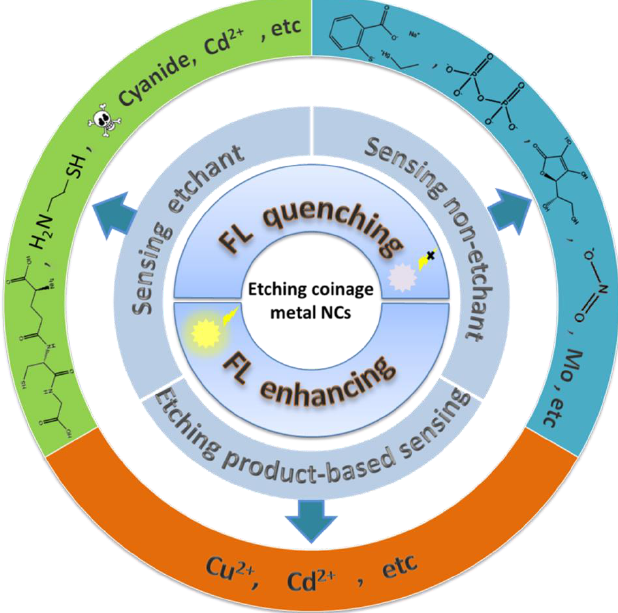
Figure 1. Mechanism diagram of sensor construction based on etched coinage metal NCs.